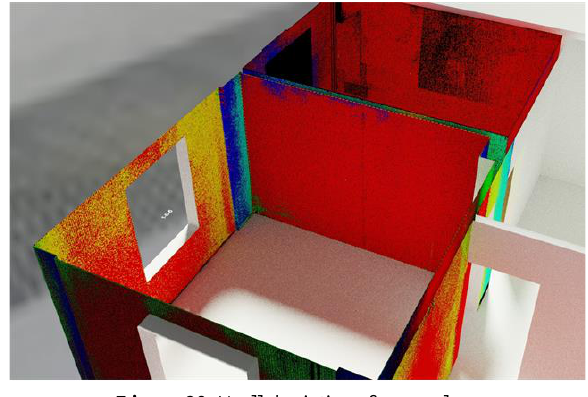
Figure 20 . Wall deviations from a plane.